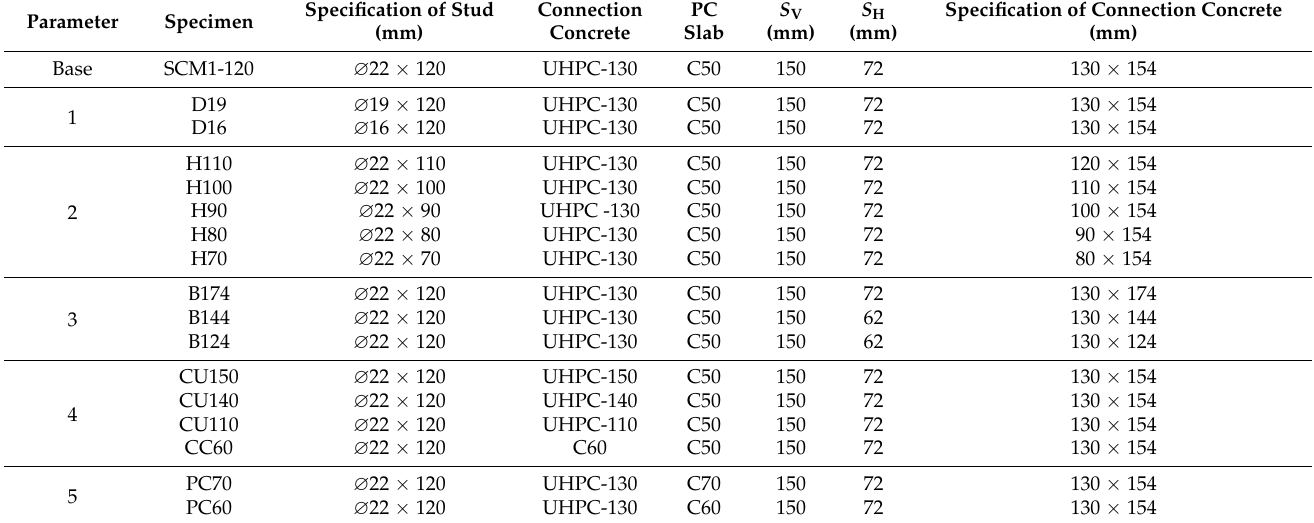
Table 4. Details of parametric analysis.